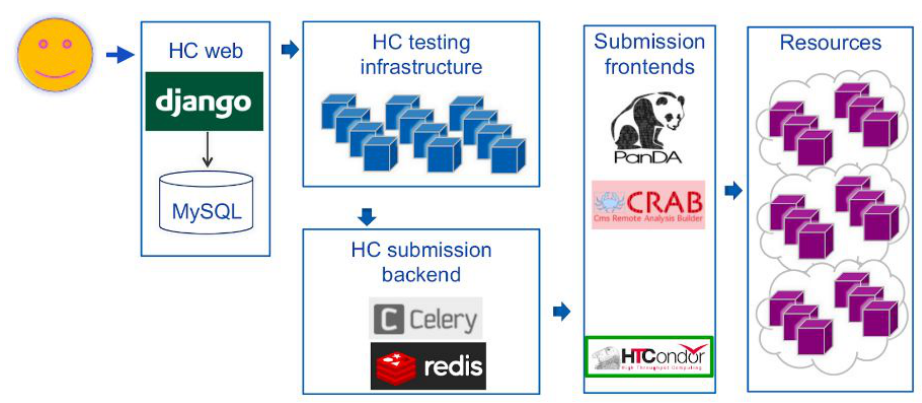
Fig. 2. HammerCloud schema overview. HammerCloud is a Django application, running on top of a MySQL database. The HammerCloud testing infrastructure runs on CERN Agile Infrastructure. The HammerCloud submission backend benefits from a Celery cluster backed by a Redis key-value store Fig. 1. ATLAS HammerCloud automatic exclusion and recovery actions. The plot shows number of for the transport layer. The HammerCloud submission backend interacts with the submission automatic actions taken monthly by HammerCloud. The exclusion actions are triggered by functional frontends, the experiment WMS (PanDA, CRAB3 [17]) or the computing element (HTCondor-CE). test job failures, usually caused by an infrastructure issue. We aim to minimize exposure of ATLAS The submission frontends interface to the resources where HammerCloud runs the physicists to the infrastructure issues. Upon addressing the issue, when the tests start succeeding again, we automatically recover the resource, re-enabling the resource for physics analysis.